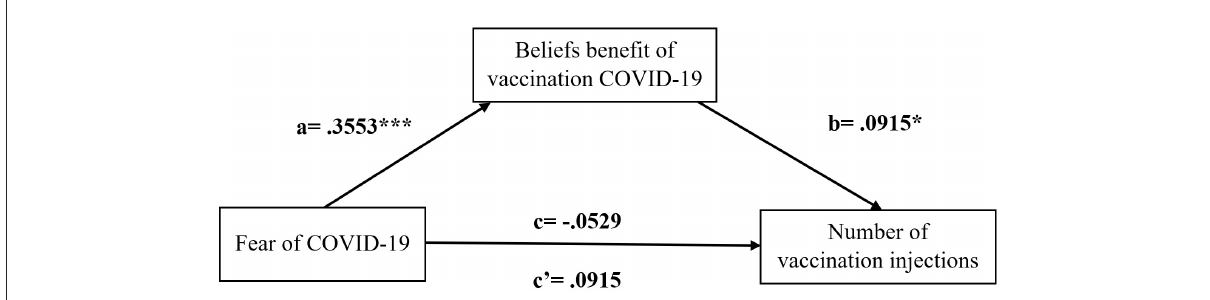
FIGURE1 Simple mediation model with unstandardized coefficients. a = total effect of fear of COVID-19 on beliefs benefits of vaccination COVID-19. b = effect of benefit on Number of COVID-19 vaccination injections. c = total effect of fear of COVID-19 on the Number of COVID-19 vaccination injections without accounting for the mediators. c’ = direct effect of fear of COVID-19 on the Number of COVID-19 vaccination injections once mediators have been included in the model. * p < 0.05, *** p <